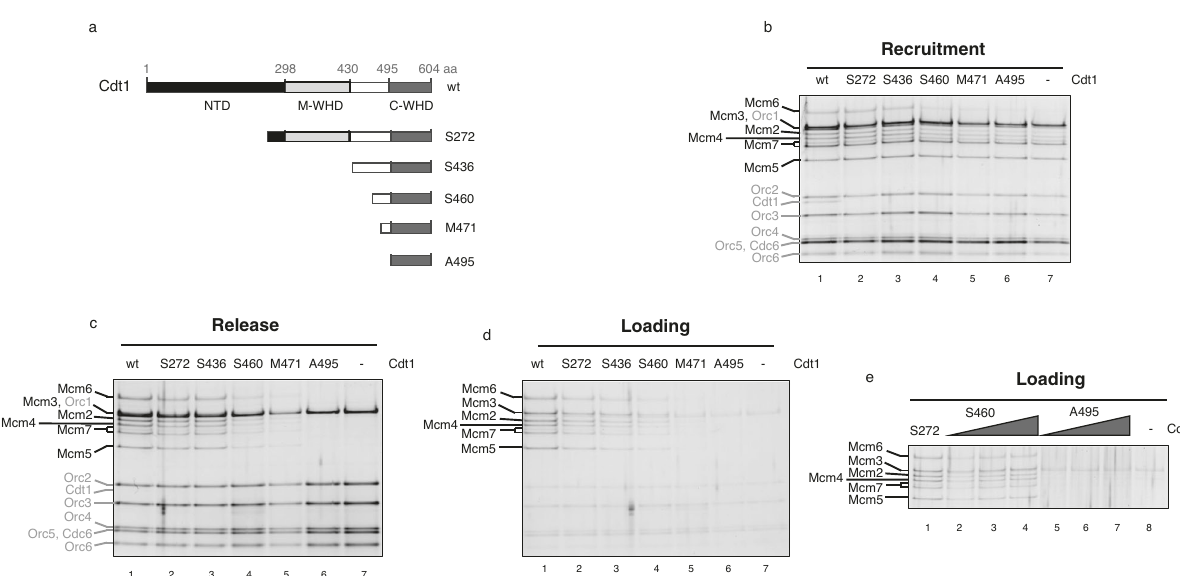
Fig. 3 An extended Cdt1 C-WHD is required to recruit half MCM onto DNA. a Scheme illustrating the Cdt1 N terminus deletions used in the preRC assay. N terminus domain is shown in black (NTD), middle WHD in light grey (M-WHD) and C terminus WHD in dark grey (C-WHD). The long loop connecting both WHDs is shown in white (from amino acid 430 – 495). The fi rst amino acid present in the Cdt1 truncations give the name to them. The S272 truncation contains a deletion of almost all NTD, while both domains, NTD and M-WHD, have been deleted in the S436 truncation. S460, M471 and A495 are different truncations affecting the length of the connecting loop and they are based on the OCCM structure (PDB: 5V8F). S460 truncation deletes mainly the loop section that interacts with Mcm2, while M471 keeps only the loop that interacts with Mcm6 C-WHD but not with the AAA + domain. Finally, A495 deletes the extension of the helix 1 of Cdt1 C-WHD and abolishes any interaction with the Mcm6 C-WHD. b Recruitment of the MCM-Cdt1 by the OC complex (ATP γ S and low salt washes), using Cdt1 wt (lane 1) or the different truncations (lanes 2 – 6). Negative control, where Cdt1 is omitted, is shown in lane 7. Under ATP hydrolysis, low salt wash is shown in c (release conditions) and high salt wash in d (loading conditions). e Loading of the MCM with increasing amounts of two different Cdt1 truncations (S460 and A495). The truncation that contains the smallest deletion (S272) is included as a positive control (Lane